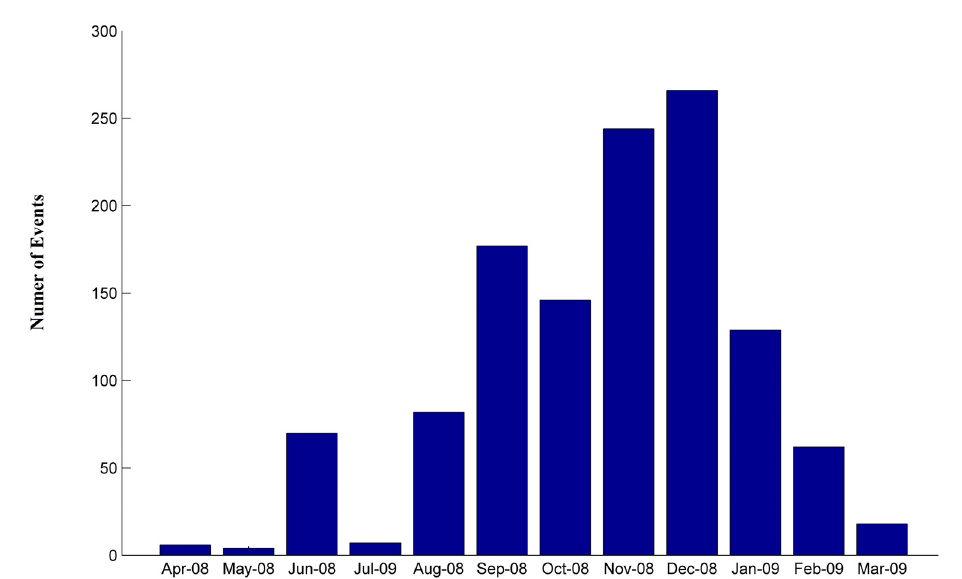
Figure 3. Frequency of events per